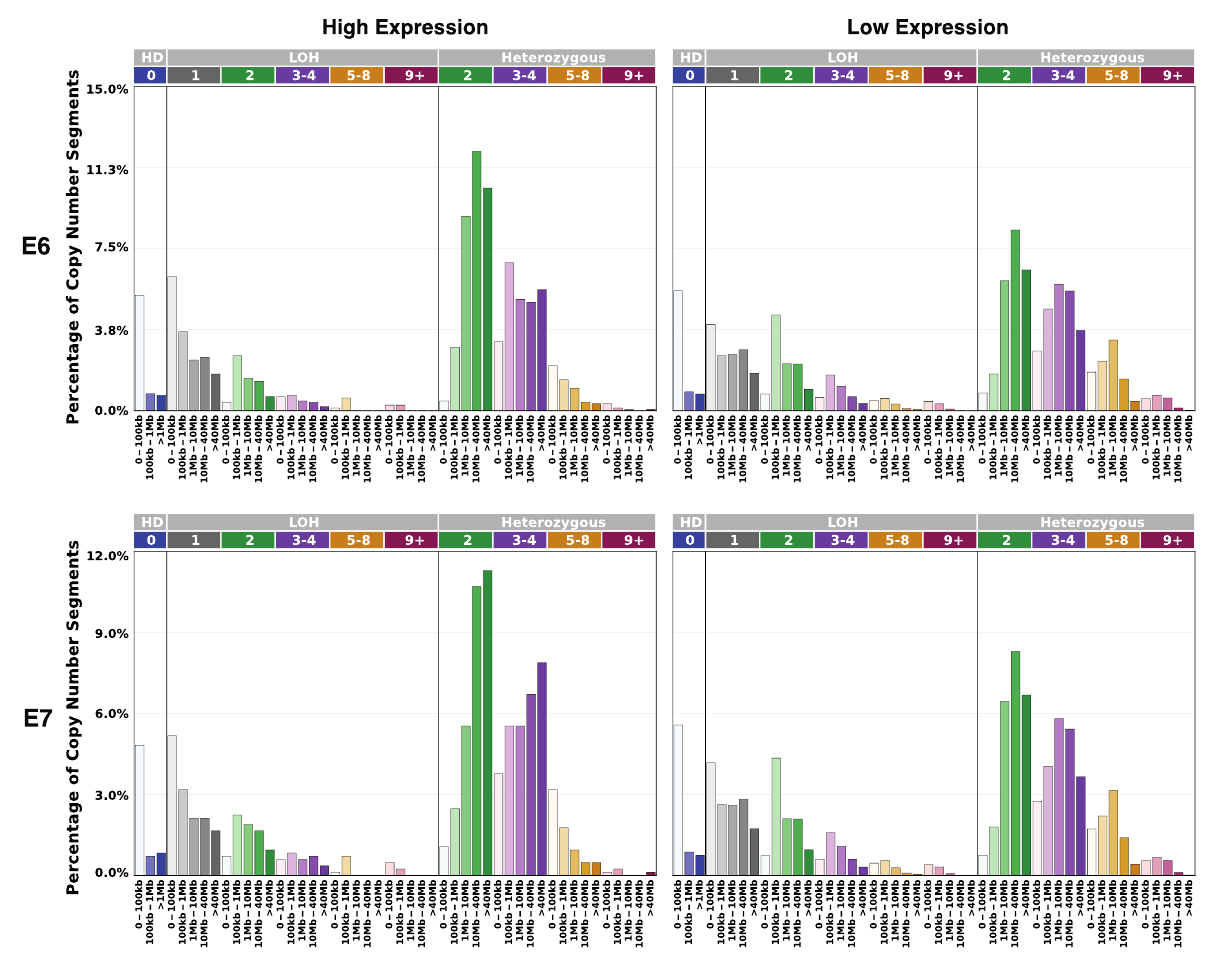
Figure 5. E6/E7 expression correlation with copy number variation. Bar plots of the percentage of segments by length across samples by E6/E7 high expression and low expression. Repeat numbers are shown, classified as heterozygous deletion (HD), loss of heterozygosity (LOH), and heterozygous repeat). Patients were categorized by individual E6/E7 TPM, with TPM ≥ 10 considered high expression, and TPM < 10 low expression.